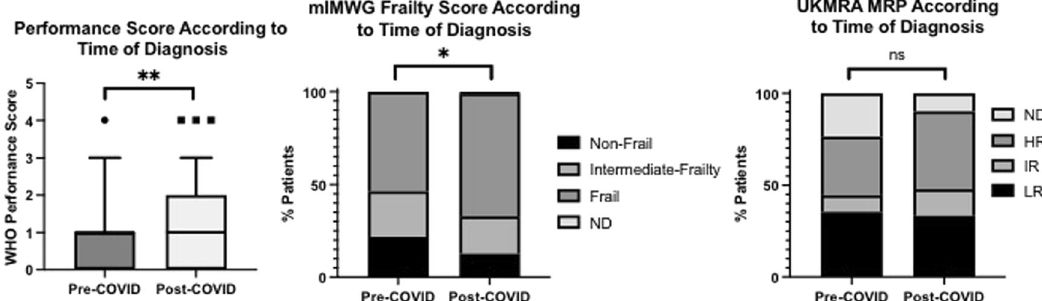
Fig. 4 Patient fi tness at diagnosis of MM, as de fi ned by WHO performance score, mIMWG FS and UKMRA MRP, in those diagnosed from 1st January 2019 – 31st January 2020 (Pre-COVID, n = 110) and from 1st February 2020 – 31st July 2021 (Post-COVID, n = 213). HR high risk, IR intermediate risk, LR low risk * p < 0.05, * * p < 0.005, ND no